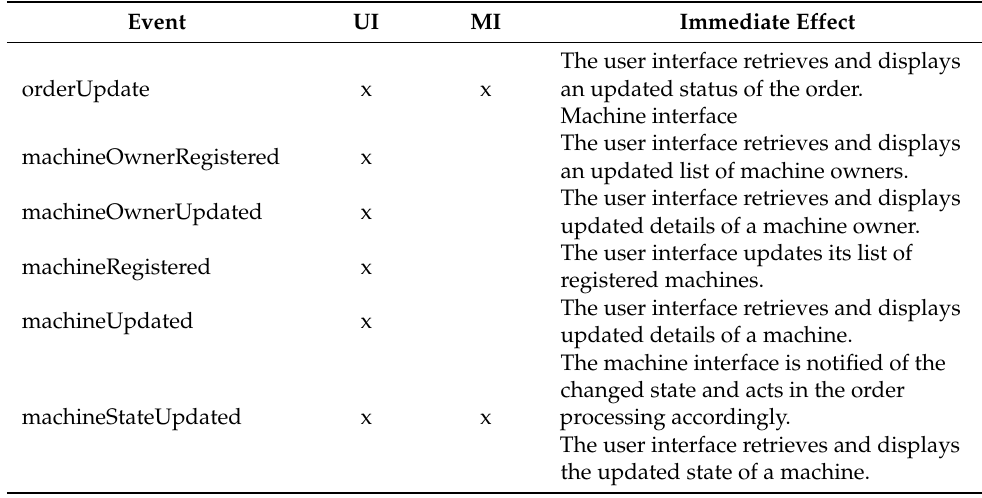
Table 2. System events and